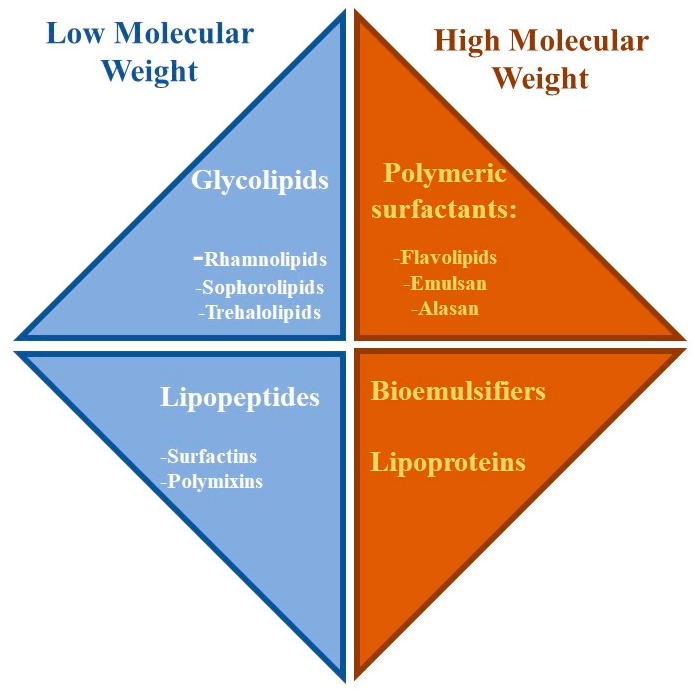
Figure 1. Classification of biosurfactants according to their molecular weight. One of the best-known families of LMW biosurfactants is that of rhamnolipids; these are glycolipids formed by one or two rhamnose units acetylated with up to three long-chain hydroxy fatty acids